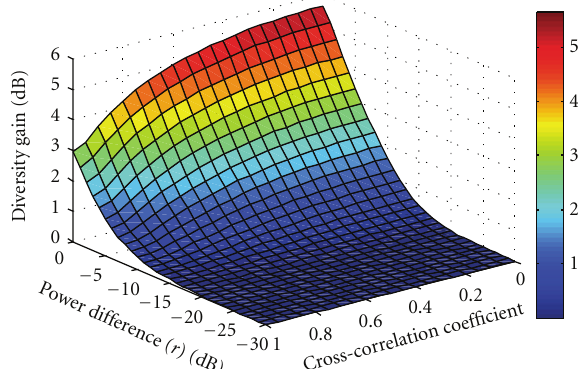
Figure 4: Diversity gain versus correlation coe ffi cient and power di ff erence between diversity branches.